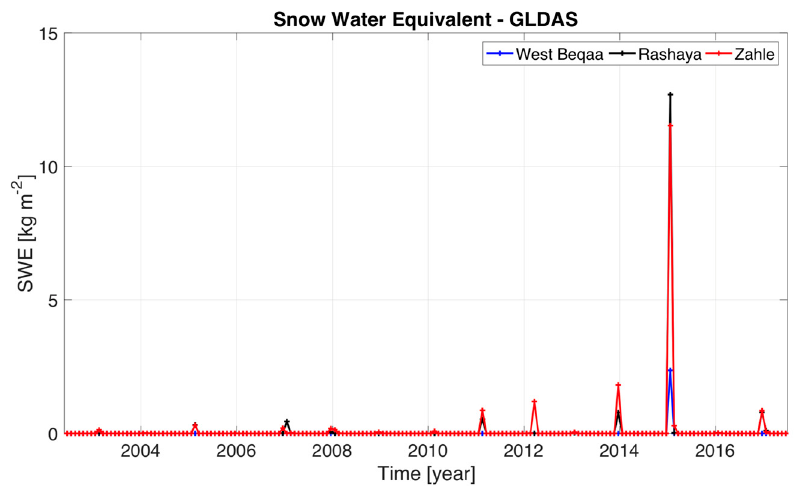
Figure 3. Soil Moisture storage in the top 10 cm (SM) from the Global Land Data Assimilation Sys- tem (GLDAS) model simulations. Three separate regions are shown.